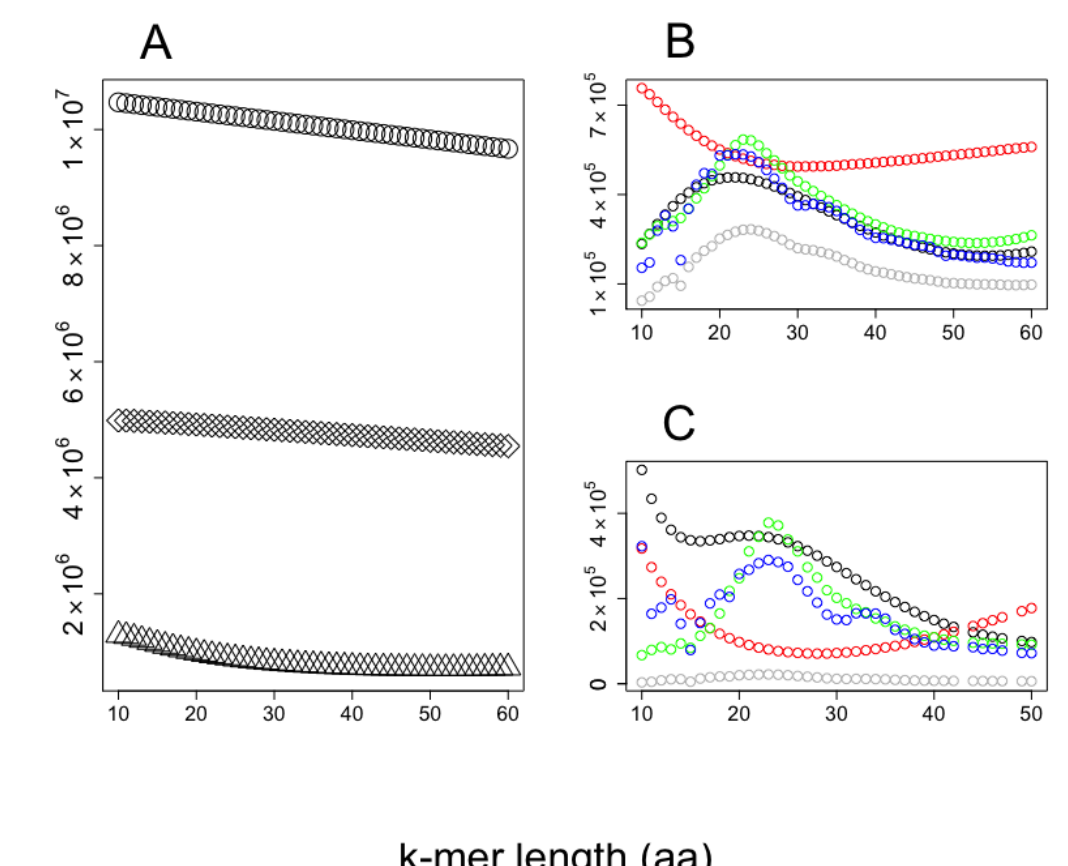
Figure 4. Frequencies of k -mers in the shrimp’s proteome. The observed frequencies of k -mers of different sizes were observed ( A ) while processing the shrimp’s proteome; the total number of k -mers are presented as circles, unique k -mers as rhombs, and those predicted as AMPs by our SVM implementation are indicated by triangles. For every k -mer predicted as AMPs in ( A ), these were analyzed by our CAMPred code to detect ( B ) antimicrobial peptides and ( C ) non-antimicrobial peptides predicted as AMPs. In this case, the four different predictors included in CAMP are reported individually: artificial neural network (red circles), random forest (blue circles), discriminant analysis (green circles), and support vector machine (black circles). ( B , C ) also show the intersection set for all these predictions (gray circles).